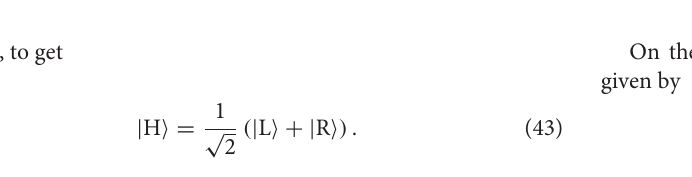
FIGURE 12 | Vertical vortex generated from the gear of N 10. The input port 1 and 2 are used to inject photons to the waveguide, and two injected modes are out = of the phase. The mode profile of a vortex is obtained at z 1 µ m above the gear. (A) Real part and (B) imaginary part of the horizontal complex electric field ( E x ). = (C) Real part and (D) imaginary part of the vertical complex electric field ( E y ). A vertical dipole is recognized for E x with a node at the center. (E–H) The local spin components (s 0 , s 1 ,s 2 ,s 3 ), and (I–L) normalised Stokes parameters (S 0 , S 1 ,S 2 ,S 3 ) are also